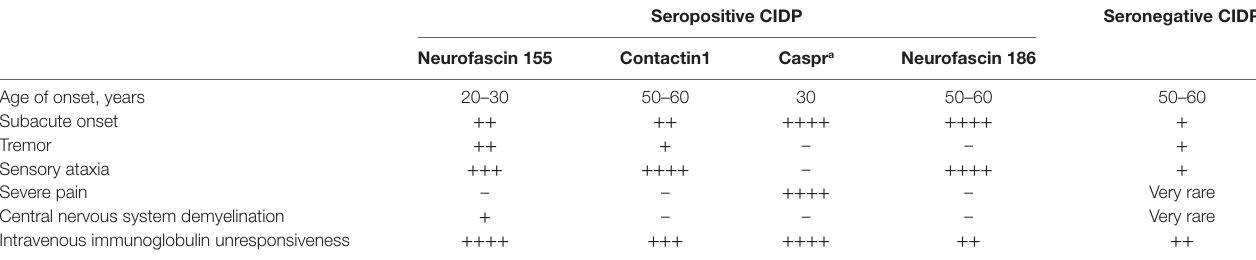
TABLe 6 | Summary of differences in the clinical phenotype between seropositive and seronegative chronic inflammatory demyelinating polyneuropathy (CIDP) patients.